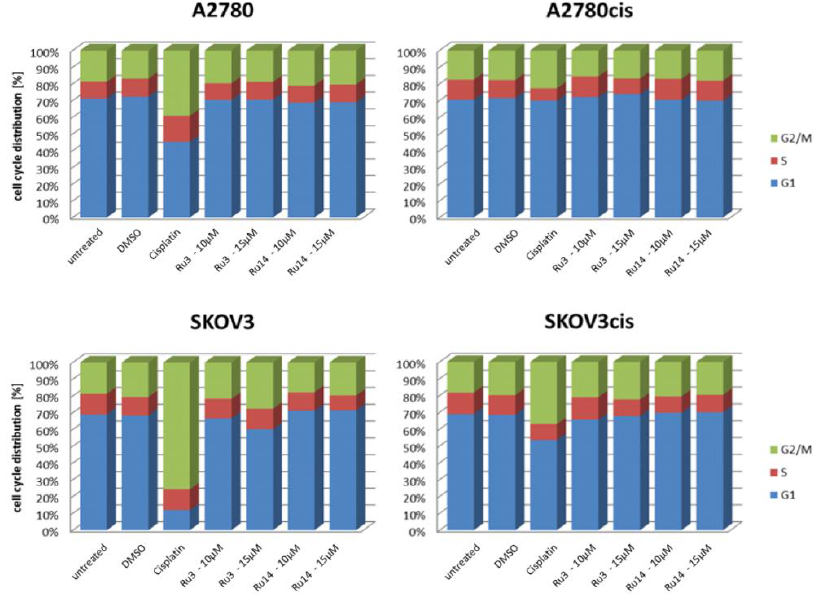
Figure 6. Cell cycle distribution of A2780 and SKOV3 cells and the resistant subcultures after treatment with 5 µM Cisplatin or indicated concentrations of Ru3/Ru14. Cells were incubated for 48h followed by a recovering time of 24 h and analyzed by PI staining and FACS.